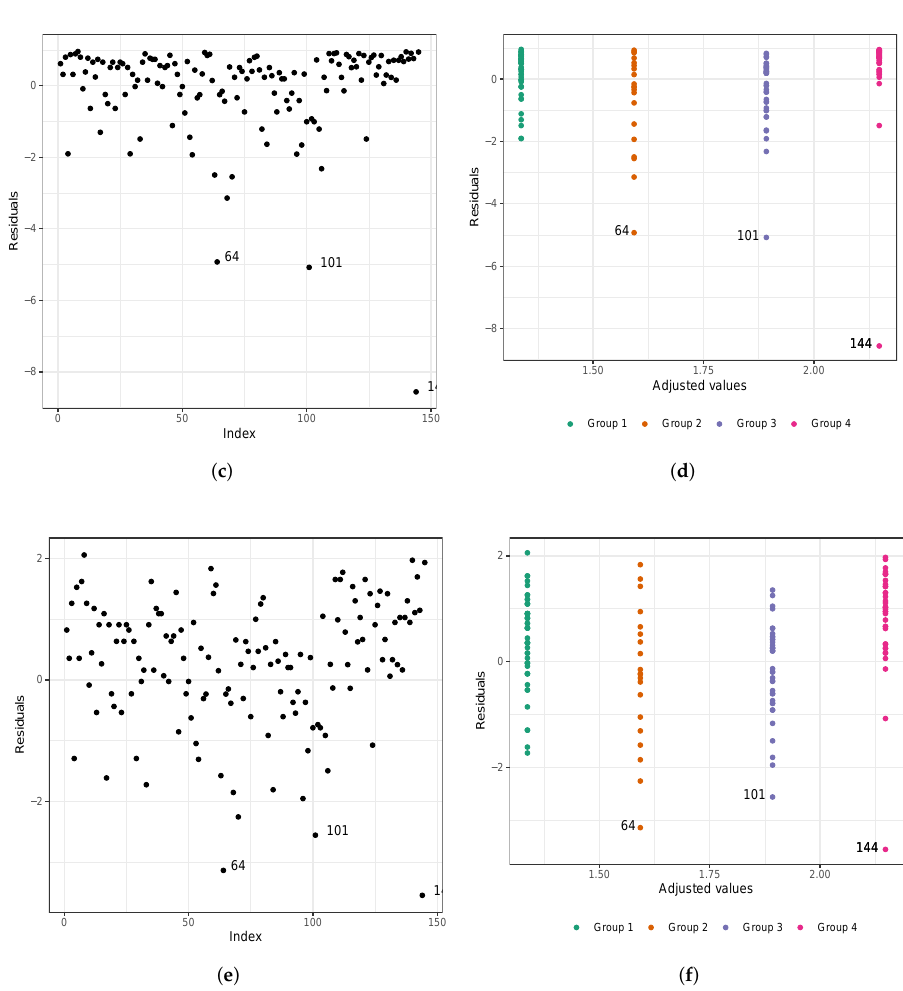
Figure 7. Plots of Cox–Snell ( a , b ), martingale ( c , d ), and deviance ( e , f ) residuals of the Weibull regression model after model selection adjusted to the data of length of stay in the surgery ward.